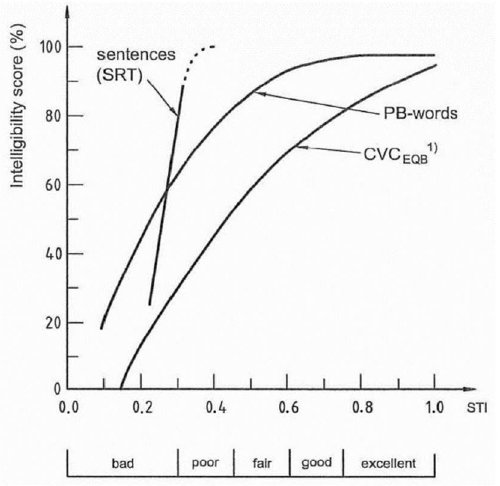
Figure 5. Comparison of intelligibility scores and STIs using three types of speech intelligibility tests.